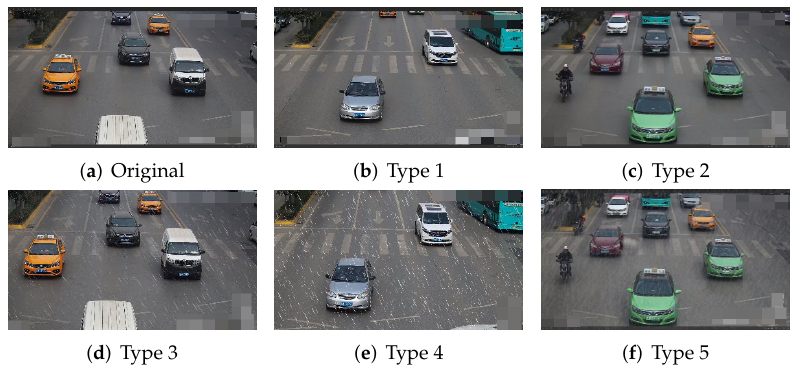
Figure 7. Rendered rain vehicle images under gray skies (the first image is original clean background image, and the rest are rendered rain images with five different types).